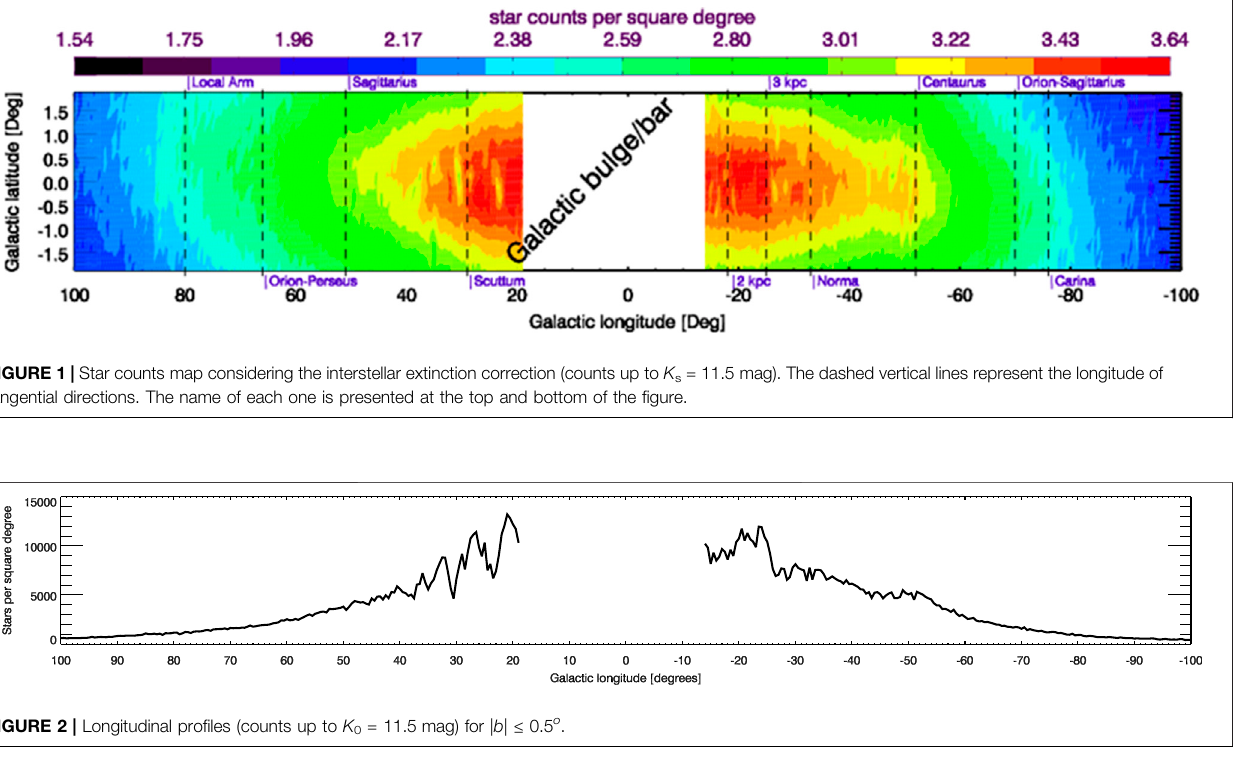
Frontiers in Astronomy and Space Sciences |